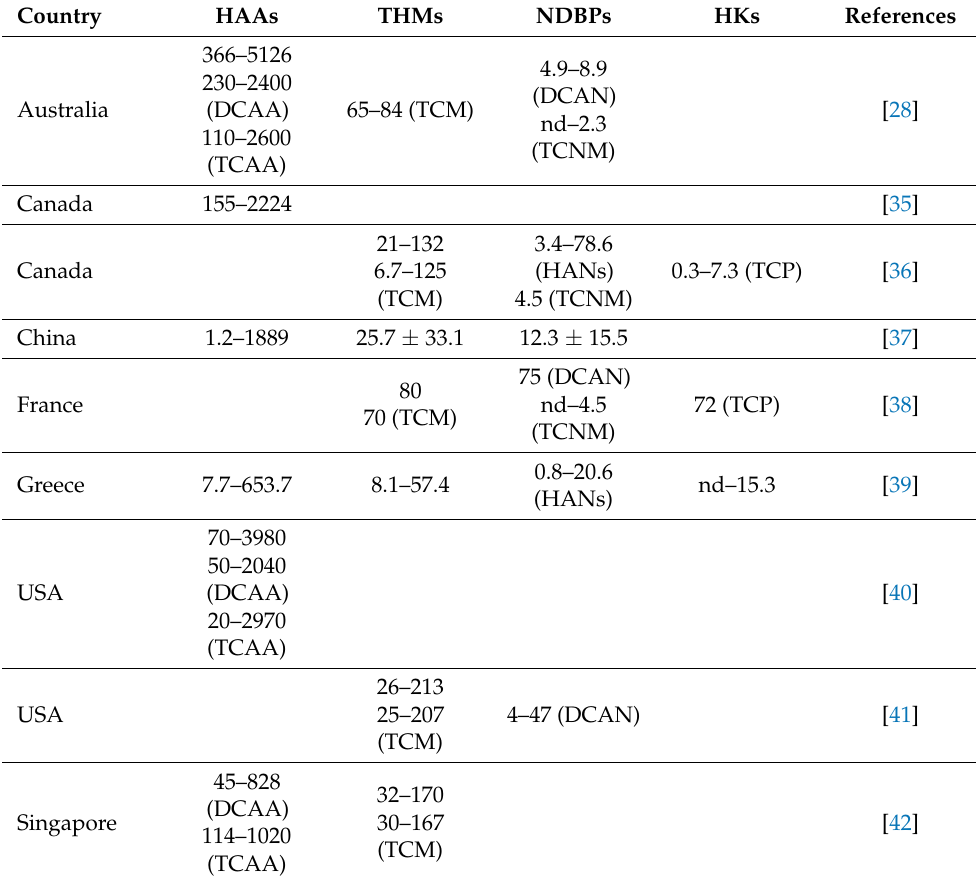
Table 5. Concentrations of DBPs ( µ g/L) in swimming pool water